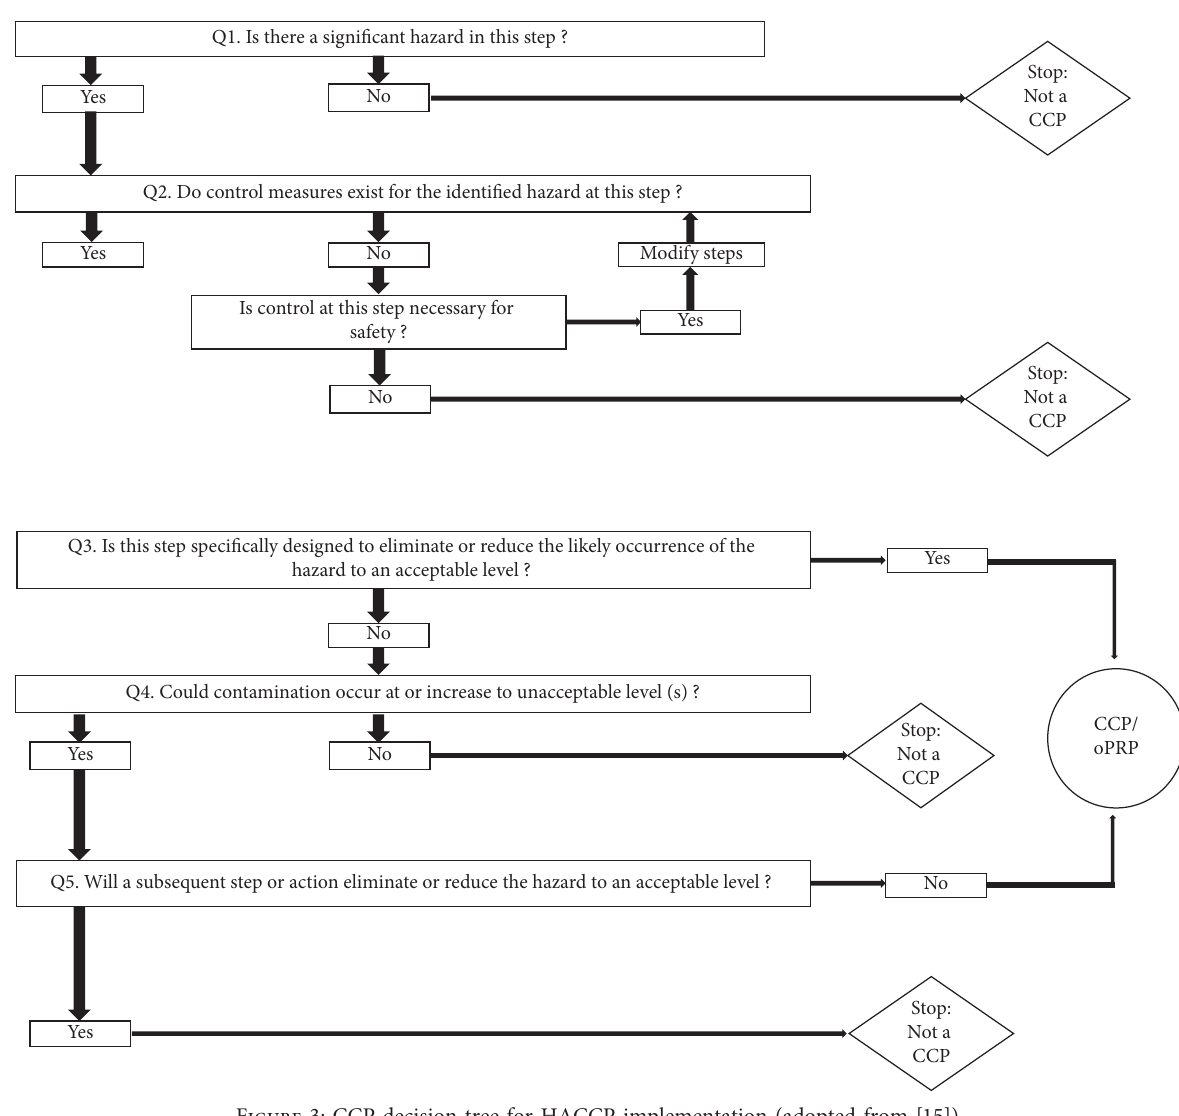
Figure 3: CCP decision tree for HACCP implementation (adopted from